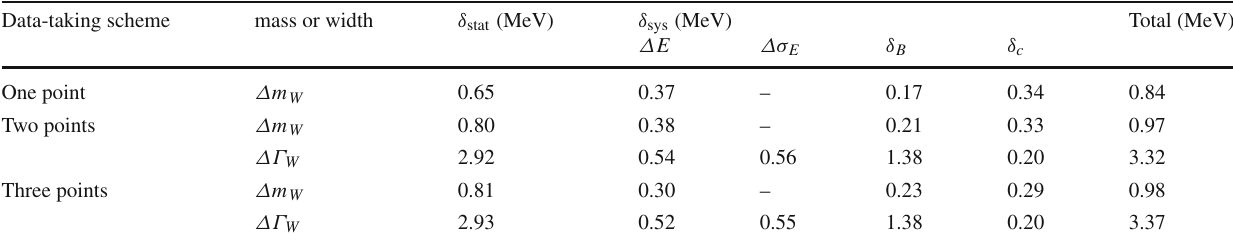
Table 3 The expected precisions of m W and Γ W with the optimized data-taking schemes. Listed are the effects of different uncertainty sources such as statistical, un-correlated systematic ( Δ E and Δσ E ), Data-taking